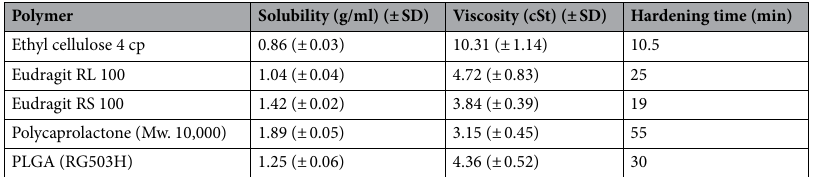
Table 2. Effect of polymer type on solubility in dichloromethane, viscosity of polymeric solution and particle size mean of microparticles.